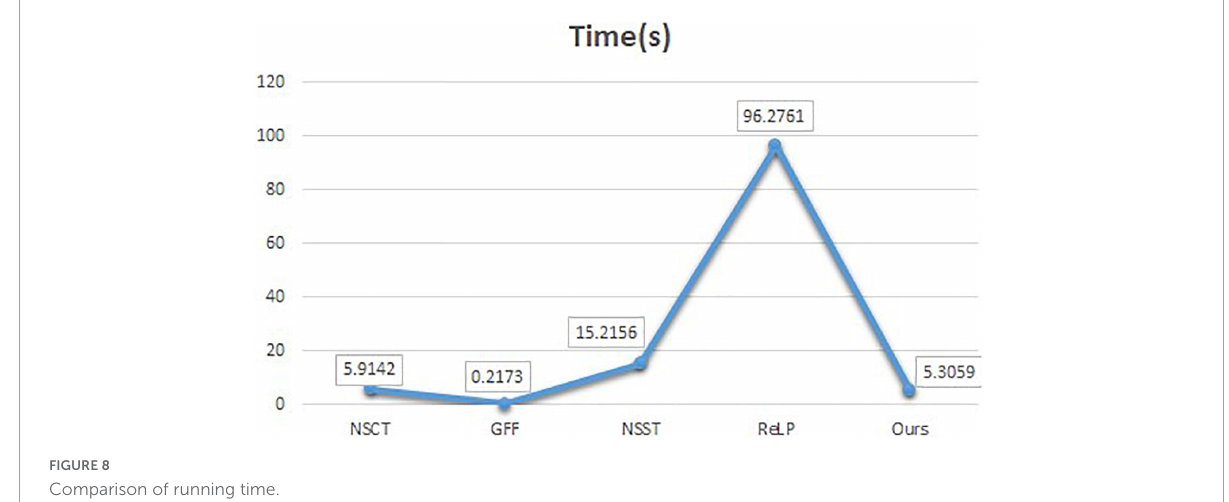
FIGURE8 Comparison of running